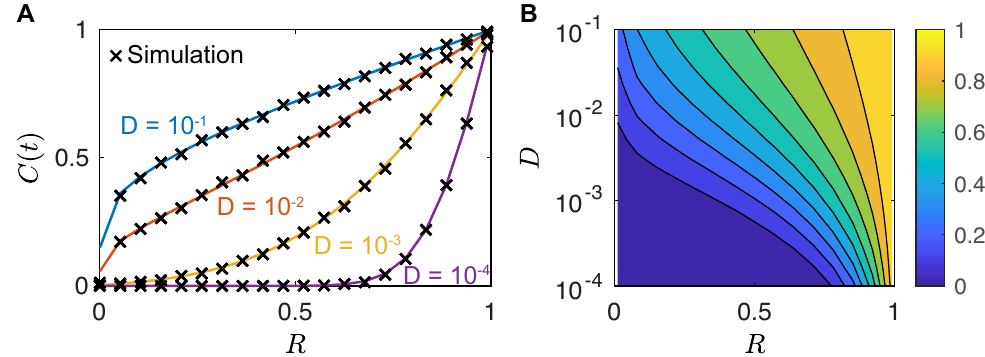
Figure 3. The probability for a male moth to reach a stationary, circular female-generated plume after t sim = 100 s in the Male Random Flight Model. ( A ) Capture and mating probability C ( t ) as a function of R = r mate / r 0 , calculated from Equation(5b) for male diffusivities D = 10 − 1 , 10 − 2 , 10 − 3 , and 10 − 4 . Numerical results obtained by simulating N = 5000 independent moths as described in Section 4.1 are overlaid. ( B ) Capture and mating probability C ( t ) plotted via contours in { R , D }